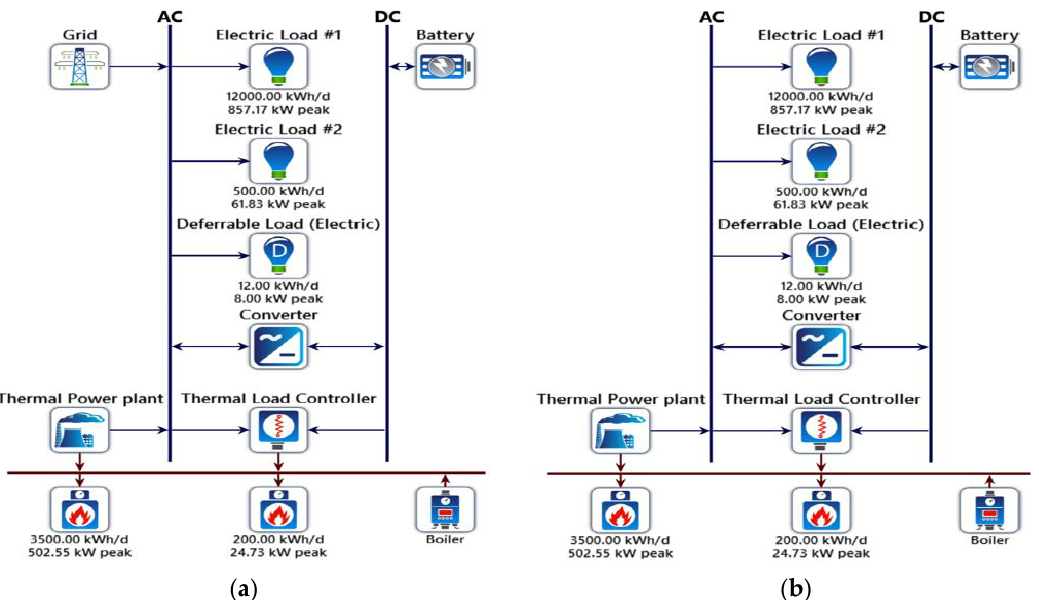
Figure 8. ( a ) Conventional small-scale grid-connected fossil fuel-based thermal energy system; ( b ) Conventional small-scale Off-grid fossil fuel-based thermal energy system.